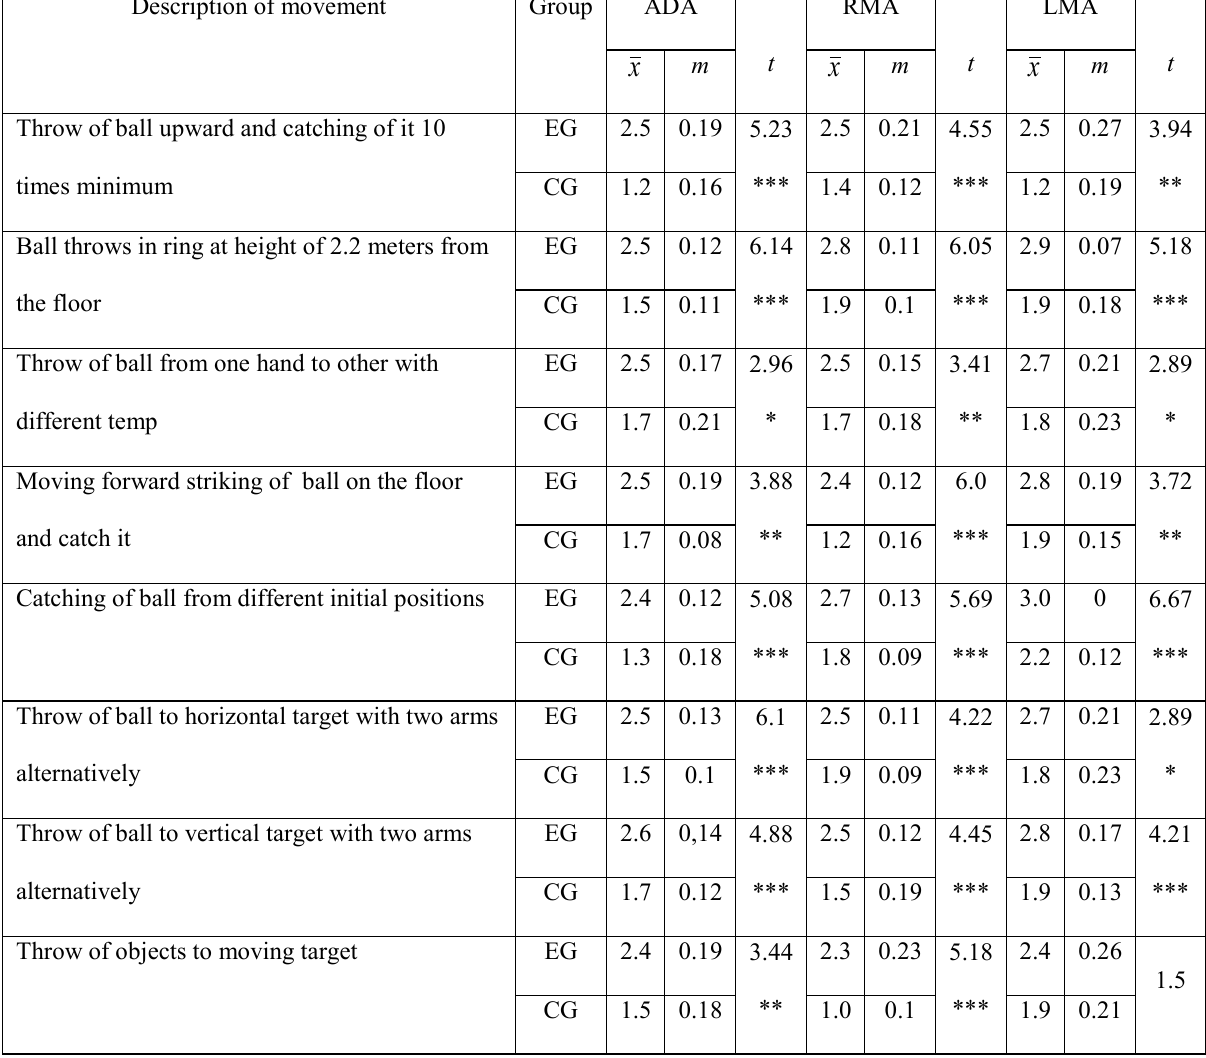
Level of manual motor skills of boys with different MMA orientation during all experiment (points) Description of movement